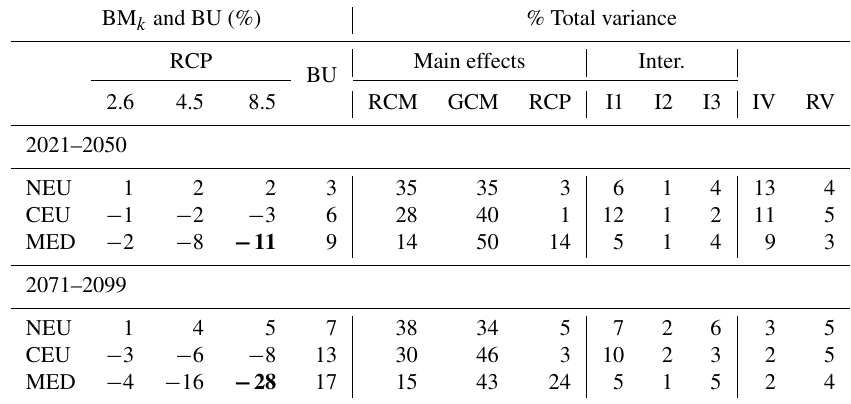
Table 5. Same as Table 2 for relative changes in total precipitation in summer